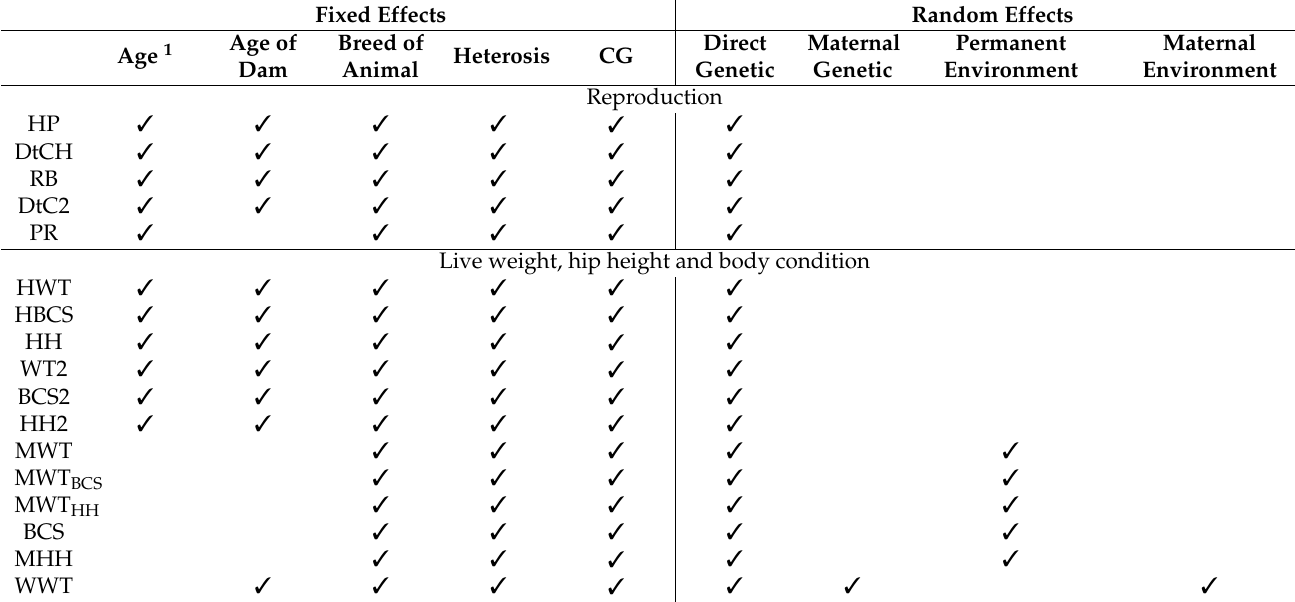
Table 3. Fixed and random effects for each trait included in the variance component